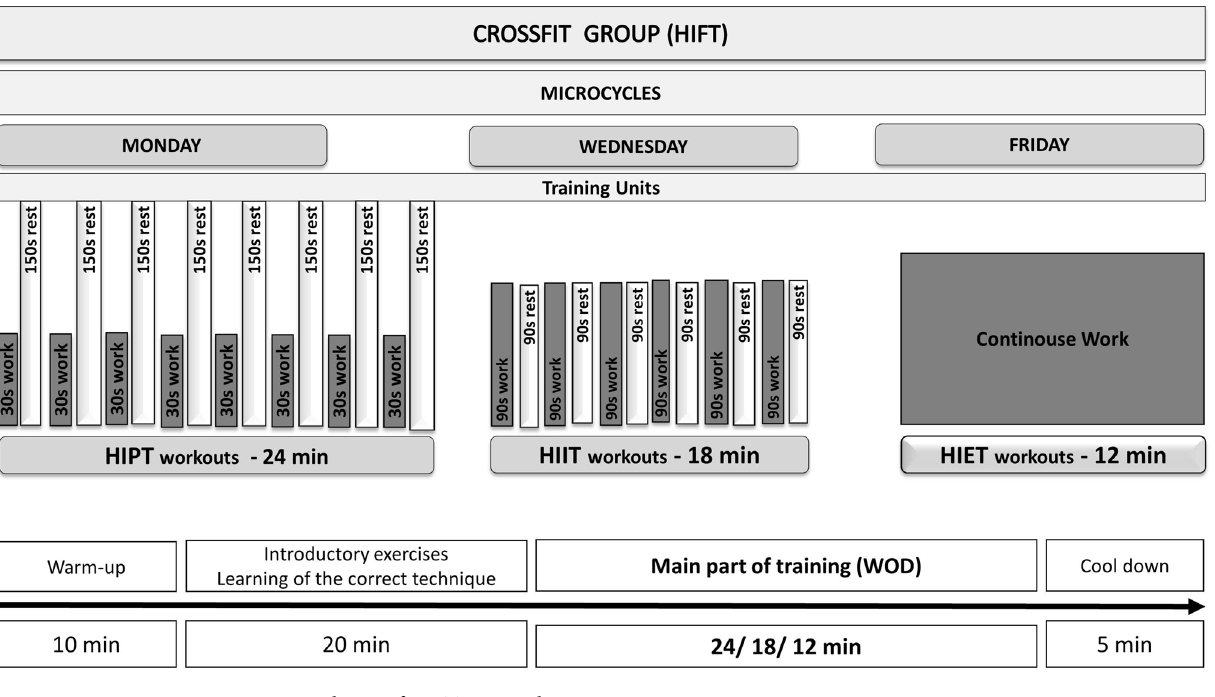
Figure 6. Scheme of HIFT